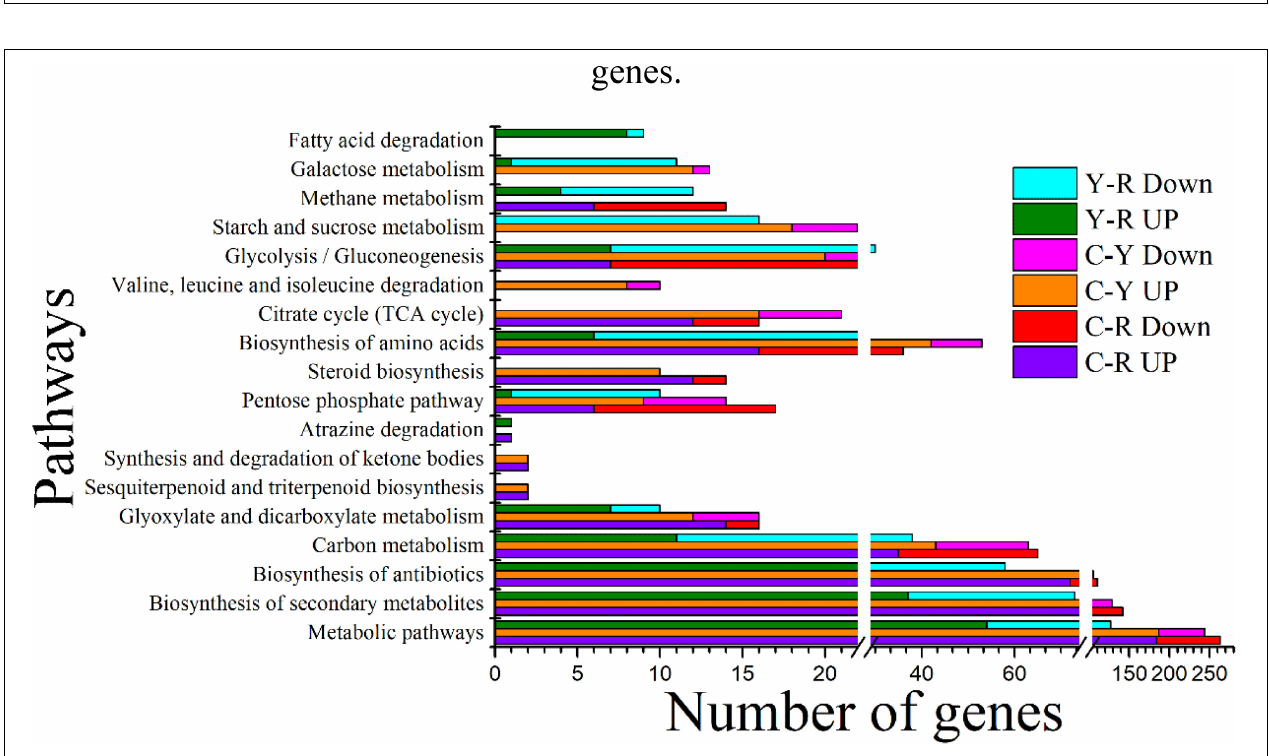
FIGURE 5 | Top 15 significant KEGG pathways identified in S. cerevisiae transcripts in response to different conditions. C-R, comparison of transcripts from the yeast cultured under between calcium acetate medium and control; C-Y, comparison of transcripts from the yeast cultured under between calcium lactate medium and control Y-R, comparison of transcripts from the yeast cultured under between calcium acetate medium and calcium lactate medium; Up, up-regulated genes; Down, down-regulated genes.